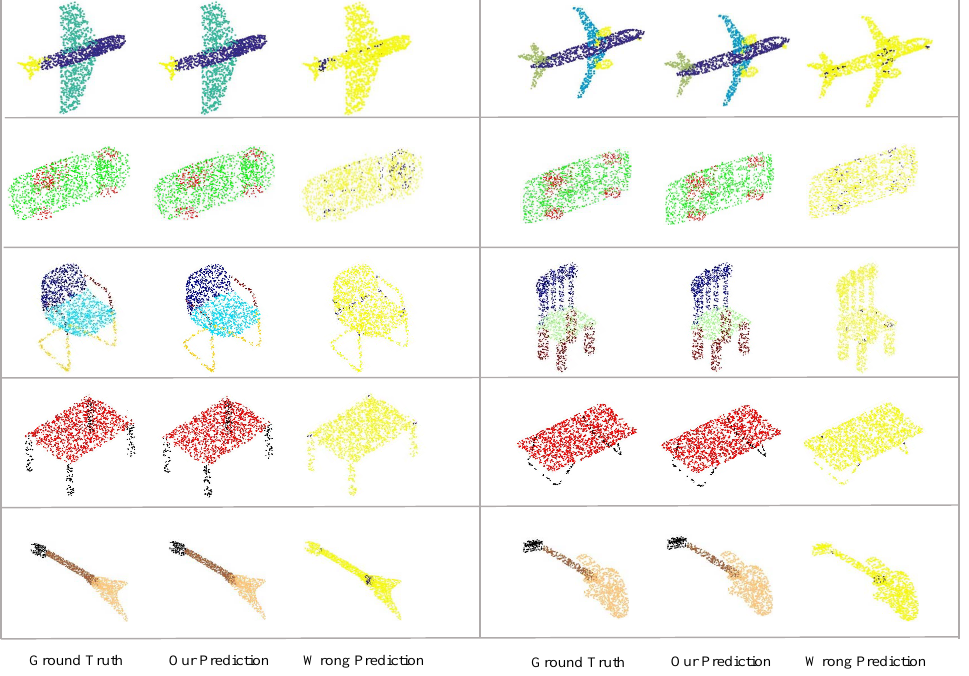
Figure 5. Shape segmentation results. In every box, we present the object with ground truth labels and our predicted labels in the first and second columns, respectively. We also highlight the wrongly predicted points with dark blue color, which are mainly located near the connection of two parts in one